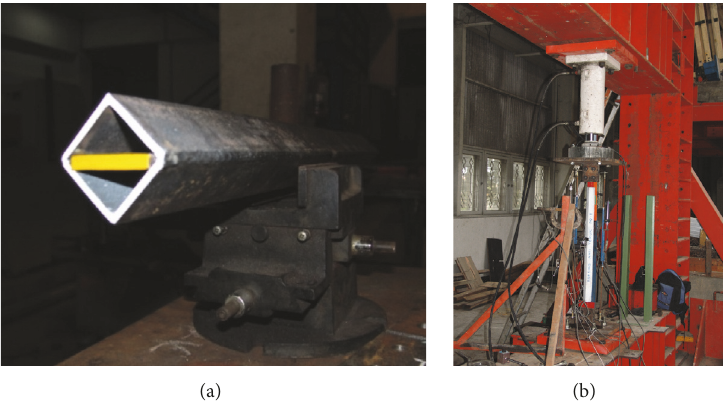
Figure 9: (a) Cross section of SBRB at midlength. (b) Setup of SBRB in the loading frame [7].